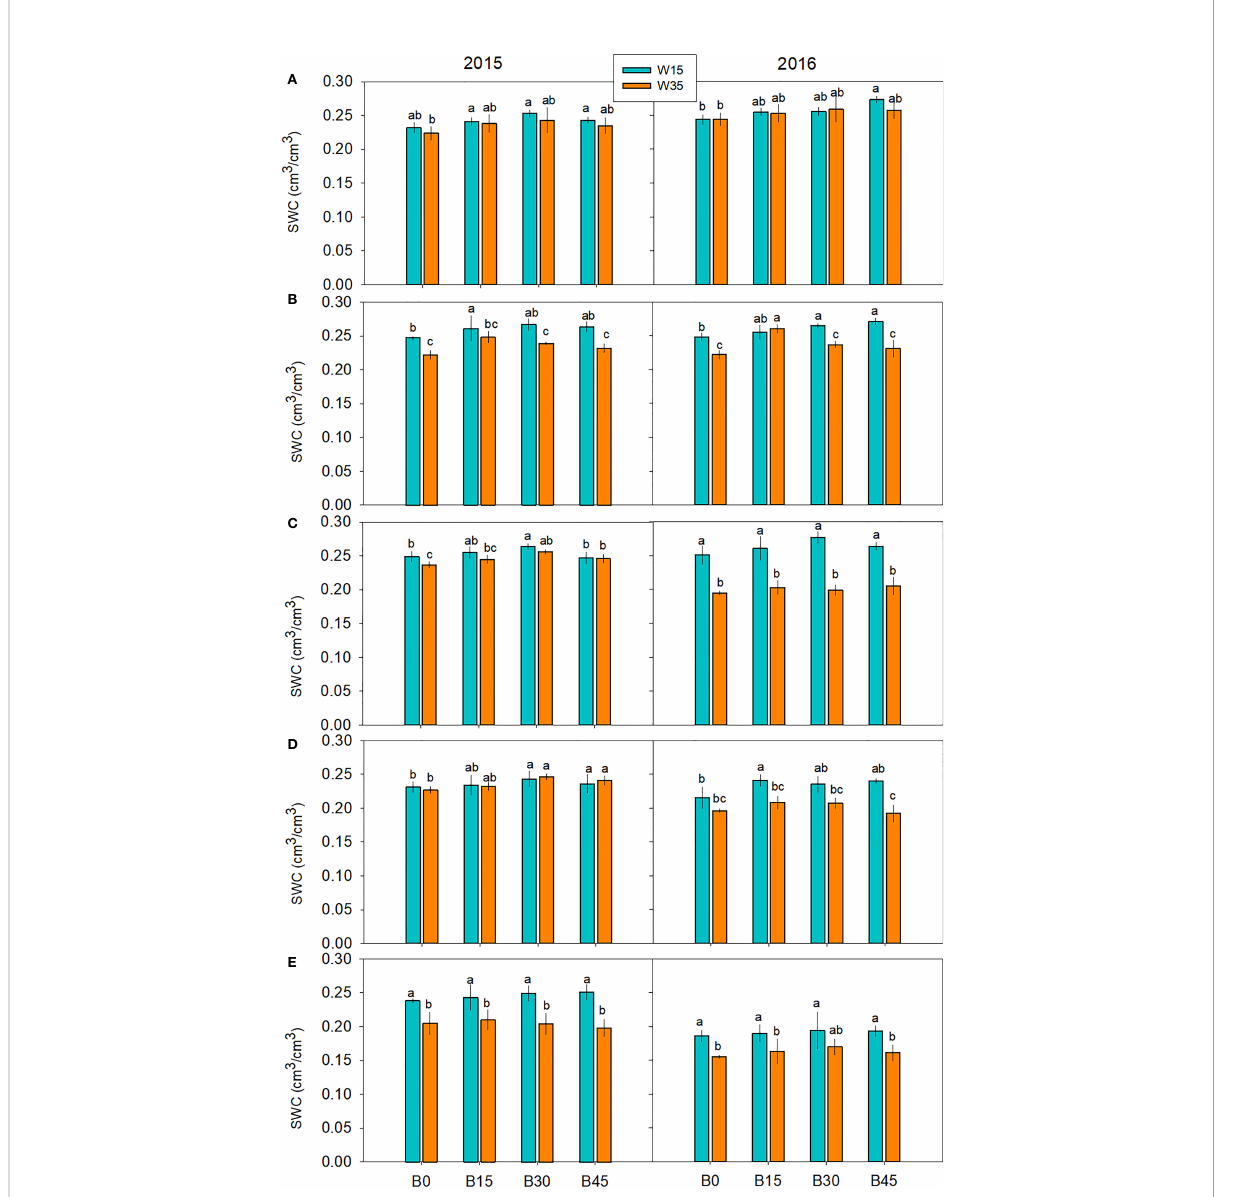
FIGURE 3 Soil water content (SWC) at top 15 cm soil layer in maize growth stages of three-leaf (A) , joint (B) , tasseling (C) , grain- fi ll (D) , physiological maturity (E) under biochar amendments (B0, B15, B30, and B45, referring as 0, 15, 30, and 45 t ha -1 ) and irrigation water lower limits at soil matric potential -15 (W15) and -35 KPa (W35) in 2015 and 2016. Different lowercase represents signi fi cant difference at P<0.05 between